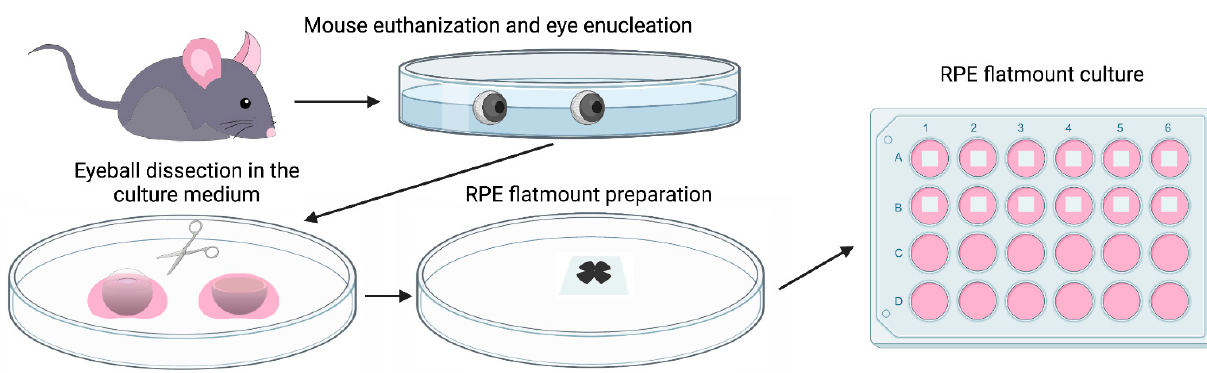
Figure 1. Diagram showing the procedure of establishing a mouse RPE explant culture. Eyes were enucleated from a euthanized wild-type C57BL/6J mouse, transferred to sterile PBS, and washed with PBS twice. After removing the connective tissue and anterior parts (cornea and lens), the resulting eyecups were cut into four petals. Neural retinae were then peeled off and the RPE/Choroid/Sclera complexes were mounted on a PVDF membrane with the sclera attached to the membrane. RPE flatmounts were then transferred to a 24 well plate with a 500 μ L culture medium (with the RPE facing down) and cultured in an incubator at 37 °C with 5% CO 2 .